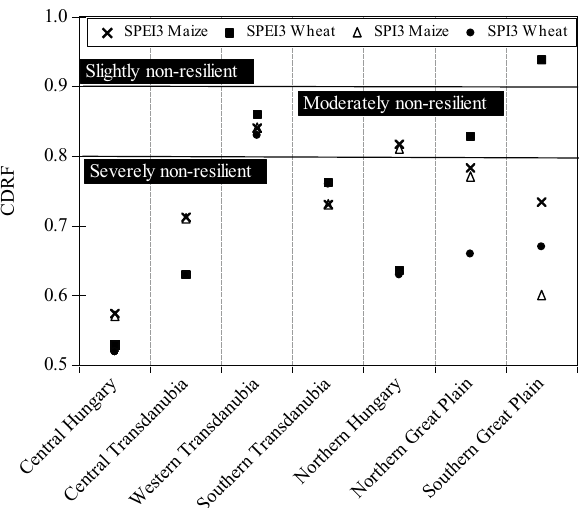
Figure 14. Crop drought resilience factor ( CDRF ) in terms of 3 months’ time scale for maize and wheat across Hungarian regions between 2000 and 2010 (figure was generated using EViews (https:// www. eviews. com/ home. html)).